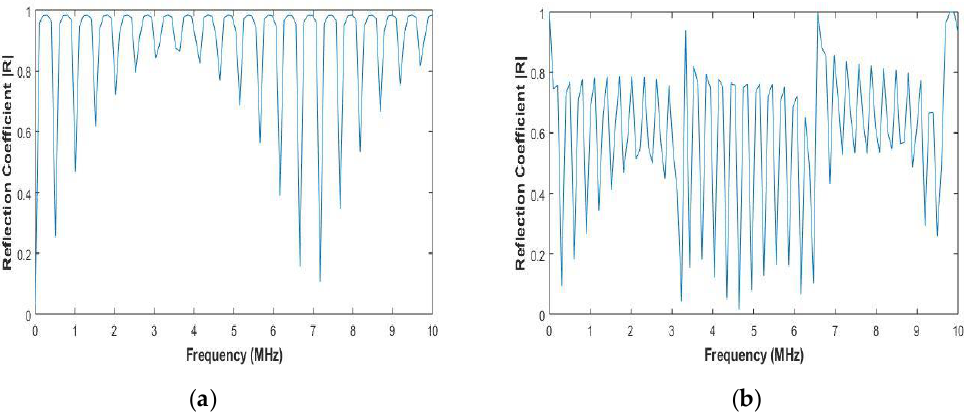
Figure 3. ( a ) Total reflection coefficient for aluminum ( b ) Total reflection coefficient for CFRP